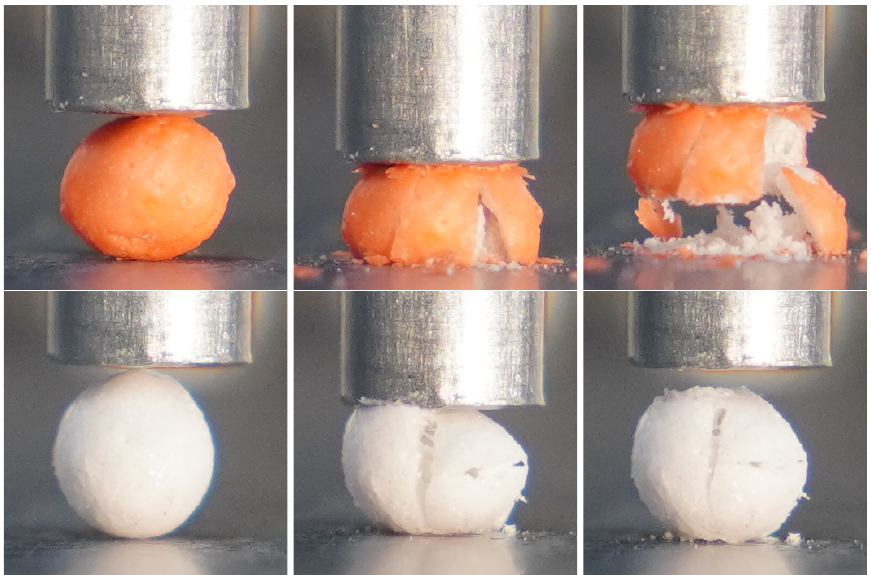
Figure 5. Three stages of single particle compression: at the start when 0.001 N force was measured ( left ), during punch motion with velocity 50 µm/s ( center ) and at the end when the punch was removed ( right ) for Cadelilla wax-coated ( top ) and silicone-coated ( bottom ) Poraver ®